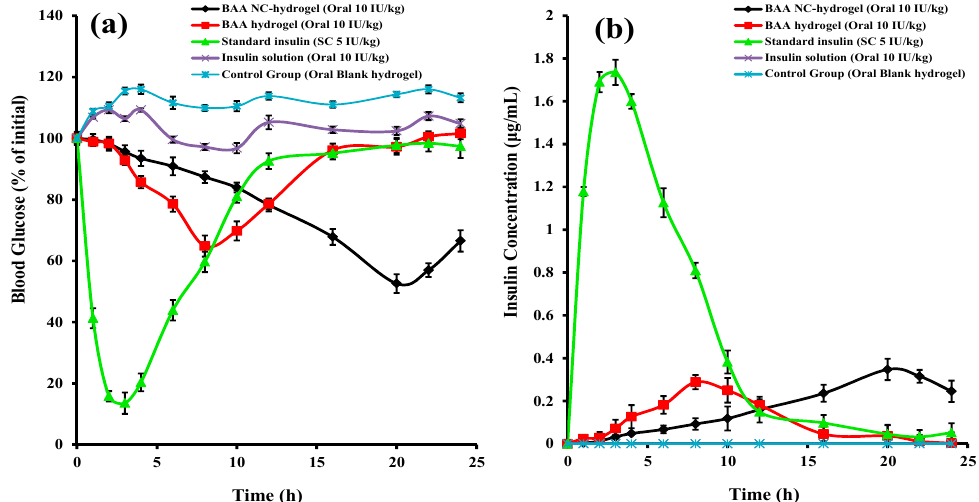
Table 7. Pharmacokinetic parameters of orally administered Ins-BA hydrogel, Ins-Mmt-BA hydrogel NC and SC standard insulin (values are significantly different * ( p < 0.05)). Figure 11. Percentage blood glucose levels of different rabbits’ groups ( a ) and their blood insulin concentrations ( b ) after oral administration of Ins-Mmt-BA hydrogel NC, Ins-BA hydrogel, blank hydrogel (control), insulin solution and SC insulin standard administration.